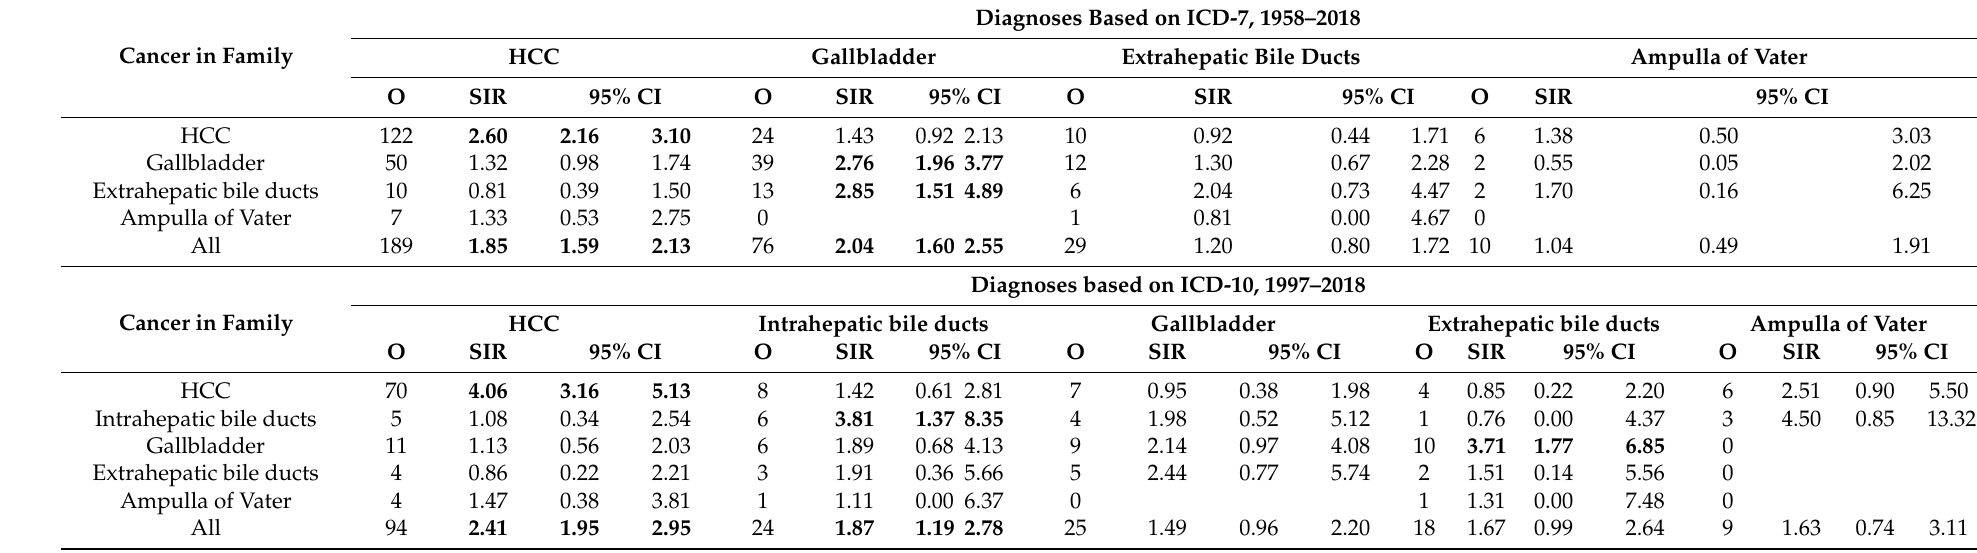
Table 3. Familial risks of concordant and discordant hepatobiliary cancer types.